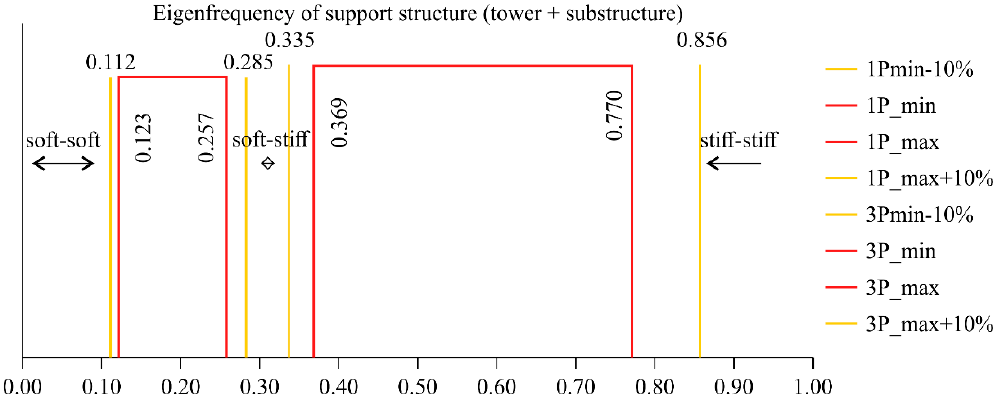
Figure 3. Design requirements of natural frequency (3 MW Turbine-D Company in Korea).